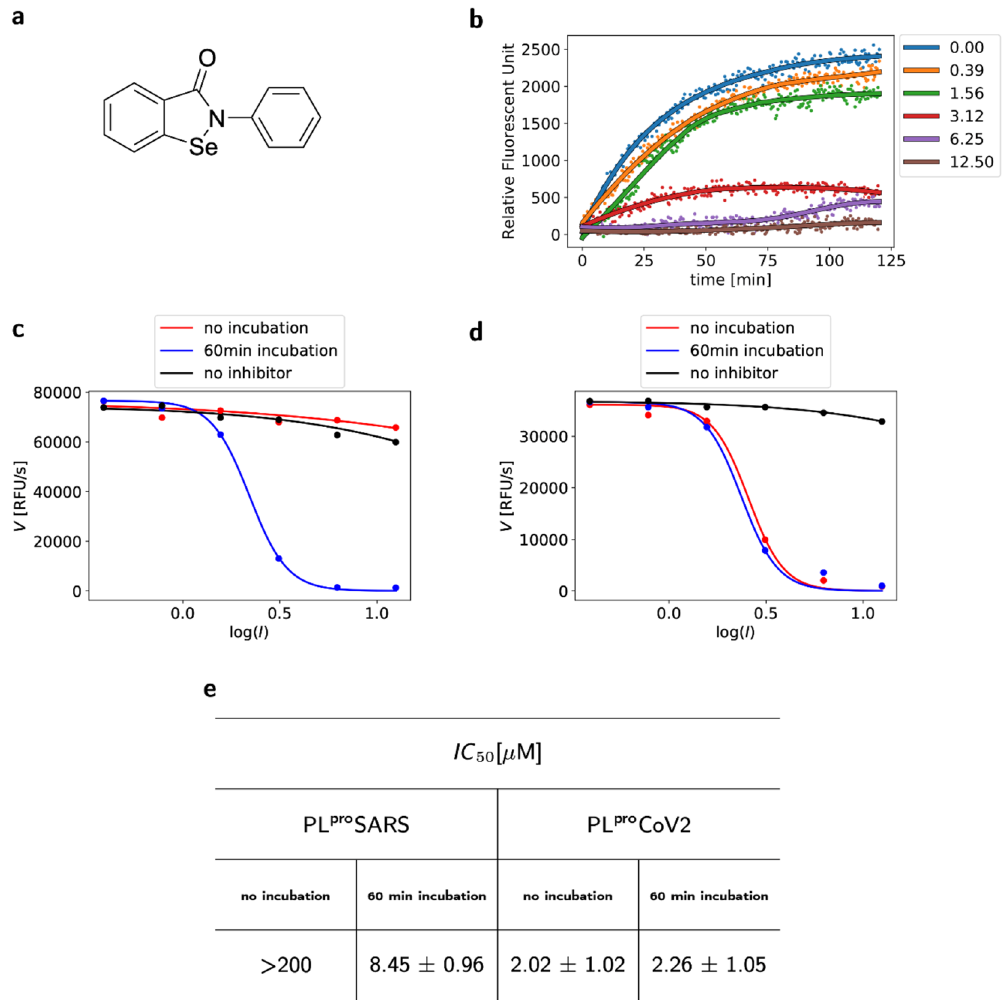
Figure 4. Ebselen inhibits PL pro CoV2 in the micromolar range. ( a ) Structure of ebselen. ( b ) Progress curves for the hydrolysis of Ub-AMC by PL pro CoV2 without and in the presence of increasing concentrations of ebselen. The concentrations of Ub-AMC and PL pro CoV2 were 500 nM and 10 nM, respectively, the concentration of ebselen is shown in the legend in μM. ( c , d ) PL pro CoV2 ( c ) and PL pro SARS ( d ) assay results for ebselen without incubation and after a 1-h incubation at 37 °C. Data points are plotted as the mean of n = 3 independent experiments, with each experiment having n = 1 independent samples. ( e ) Inhibitory activities of ebselen toward PL pro from SARS and